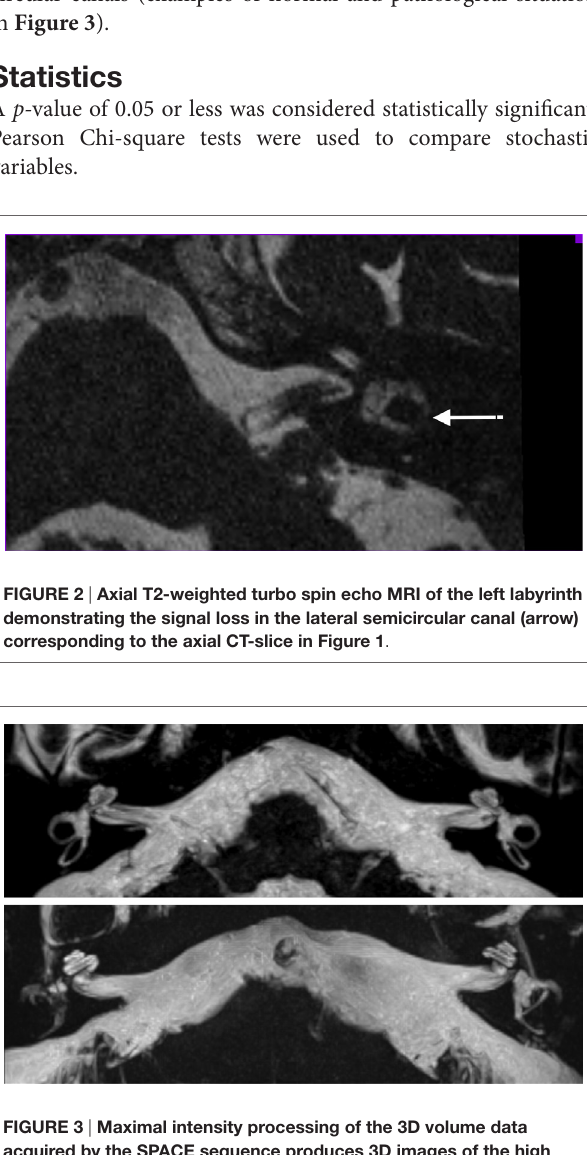
FigUre 3 | Maximal intensity processing of the 3D volume data acquired by the sPace sequence produces 3D images of the high intensity structures of the labyrinth . Above, bilaterally normal semicircular canals; under, right-sided signal loss in the lateral and posterior semicircular canals, left-sided signal loss in the lateral semicircular canal and slight narrowing in the posterior semicircular canal.